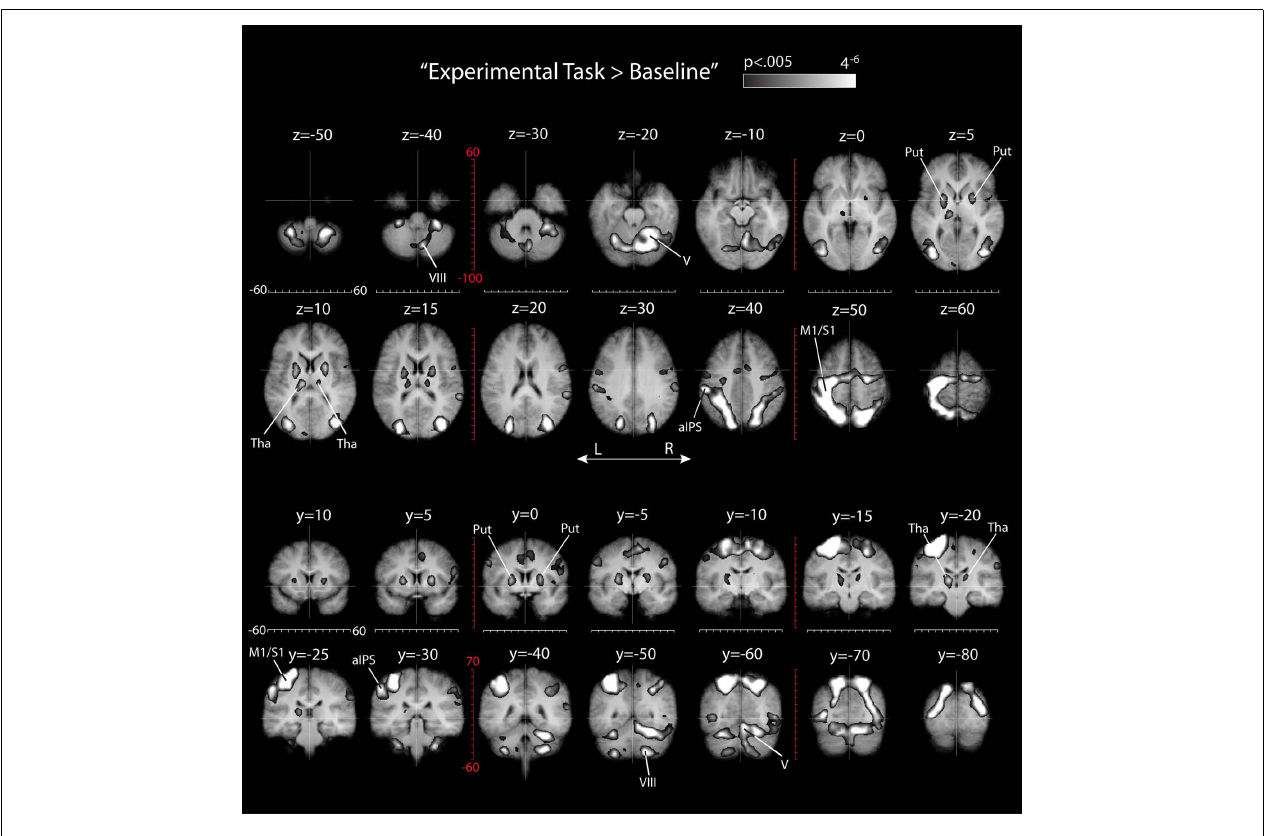
basal ganglia, and thalamus. Top panels: transverse slice views of activation foci and stereotactic coordinates (Talairach andTournoux, 1988). The numerical values above each panel denote the z -dimension, white gridlines denote the x -dimension, and red gridlines denote the y -dimension inTalairach-space. Bottom panels: coronal slice views.The numerical values above each panel denote the y -dimension, white gridlines denote the x -dimension, and red gridlines denote the z -dimension